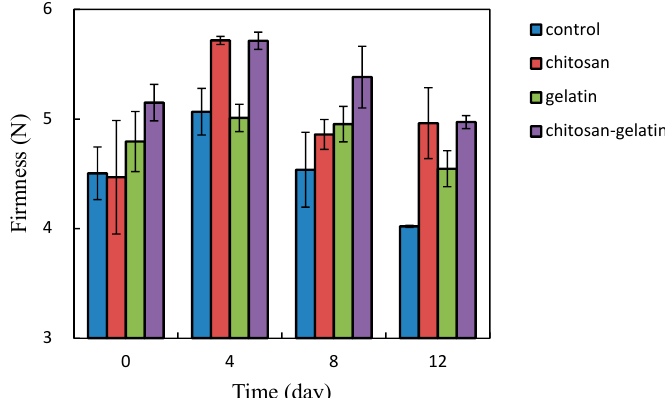
Figure 3. E ff ect of the di ff erent coatings on the firmness of fresh-cut apple during 12 days of storage at Figure 3. Effect of the different coatings on the firmness of fresh-cut apple during 12 days of storage 5 ◦ C. Data are the mean ± at 5 °C. Data are the mean ± SD.